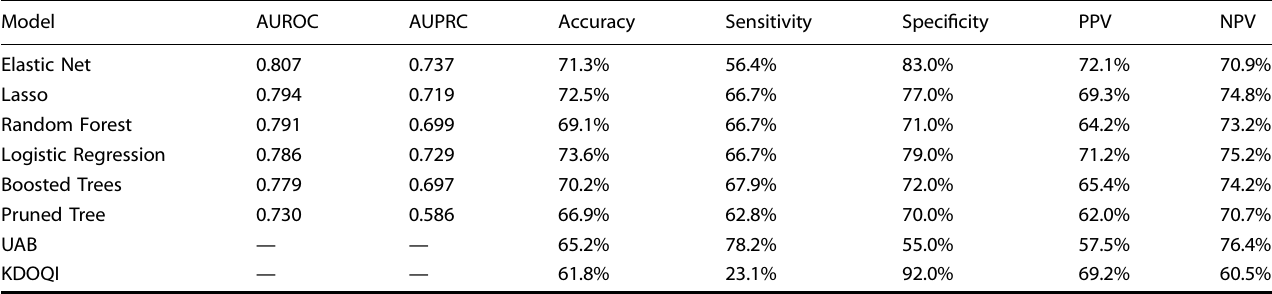
Table 3. Comparison of model performance in the hold-out testing